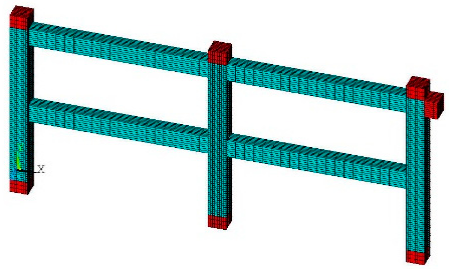
Figure 15. Meshing of the